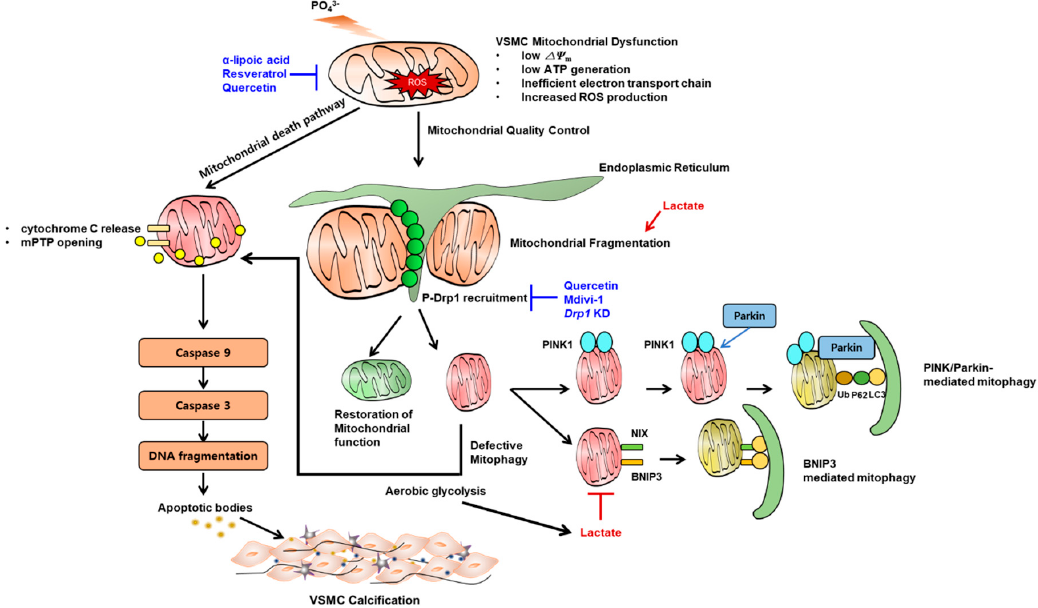
Figure 3. Key mechanism by which mitochondrial dysfunction contributes to vascular calcification. High phosphate induces vascular smooth muscle cell (VSMC) mitochondrial dysfunction represented by low mitochondrial membrane potential, low ATP synthesis and increased reactive oxygen species as a result of ine ffi cient electron transport chain. This leads to release of mitochondrial permeability transition pore (mPTP) and release of cytochrome C which in turn, induces a subsequent cascade of caspase-9 and caspase-3 activation and apoptosis. Mitochondria require quality control in the presence of mitochondrial stress. The representative phenomenon is mitochondrial fission which is mainly mediated by phosphorylated Drp1 recruitment on the site of fission. Once fragmented, dysfunctional mitochondria undergo mitophagy (canonical PINK1-parkin mediated or BCL2-Interacting Protein 3 (BNIP3) mediated). When mitophagic clearance is defective, dysfunctional mitochondria undergo apoptosis. Dysfunctional mitochondria tend to rely on aereobic glycolysis rather than oxidative phosphorylation which might further produce lactate. Lactate promotes mitochondrial fission and blocks mitophagy, both of which promote apoptosis. Some chemicals are preventive in experimental models of vascular calcification (shown in blue text, also see main text).